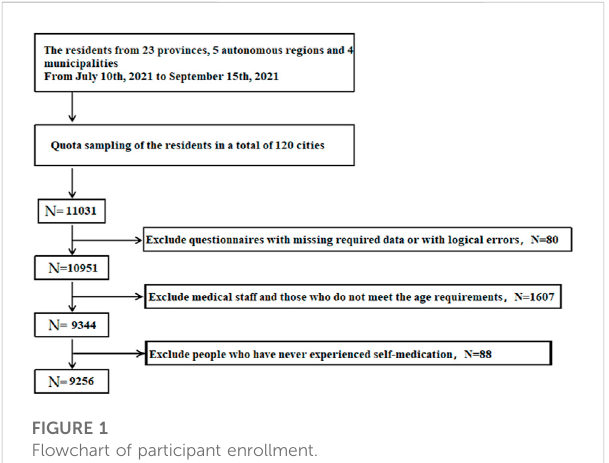
FIGURE 1 Flowchart of participant